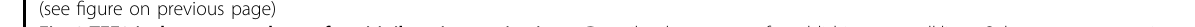
Fig. 2 TFE3 is the core regulator of sunitinib resistance in vivo. a Describe the process of establishing two cell lines. Subcutaneous tumorigenesis in mice using 786 O cell lines stably expressing TFE3. Control group received DMSO (blue) treatment and experimental group received sunitinib (yellow) treatment. After three generations of treatment, the primary cells were extracted named 786 O/OE and 786 O/OE-SR correspondingly. b , c Weight of tumor xenografts in mice of every generation (two-tailed Student ’ s t test and two ways ANOVA, * P < 0.05, NS: not signi fi cant). d Tumor volume of every generation (two-tailed Student ’ s t test and two ways ANOVA, * P < 0.05, NS: not signi fi cant). e Representative images of IHC